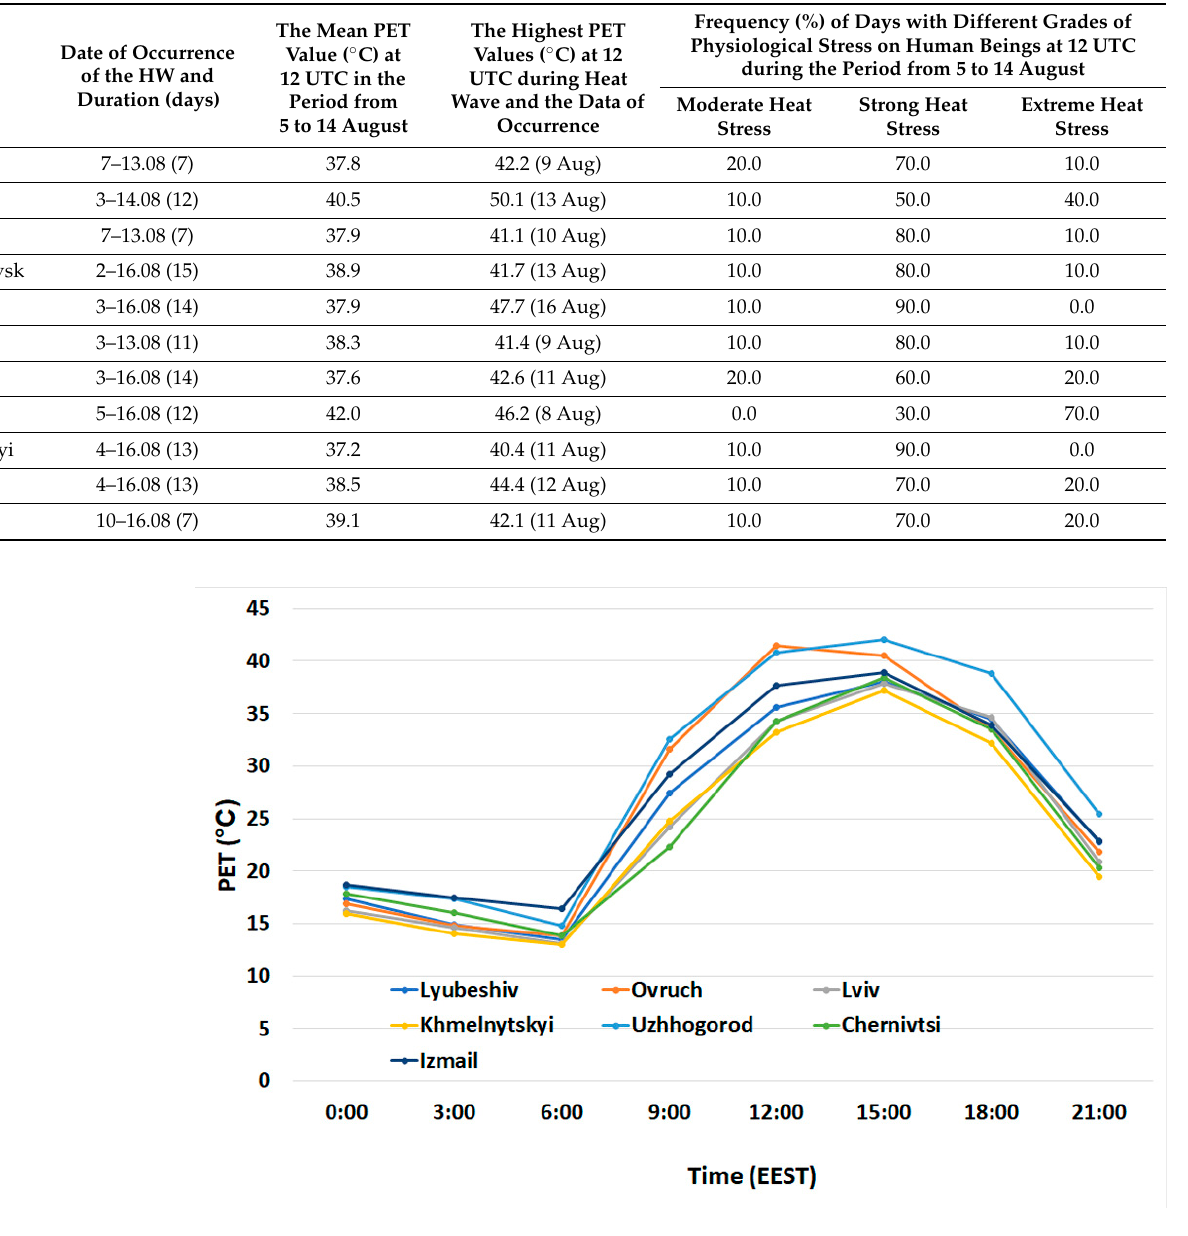
Table 6. Characteristics of the heat wave in August 2015.